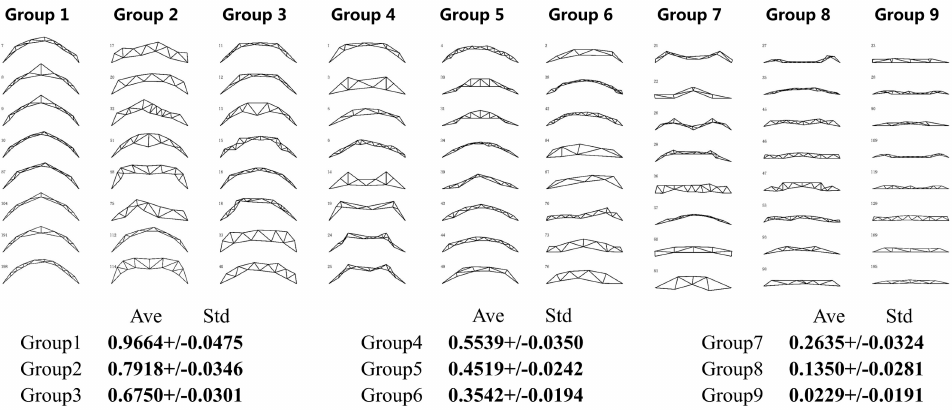
Figure 3. Part of the resulting graph of height-span ratio